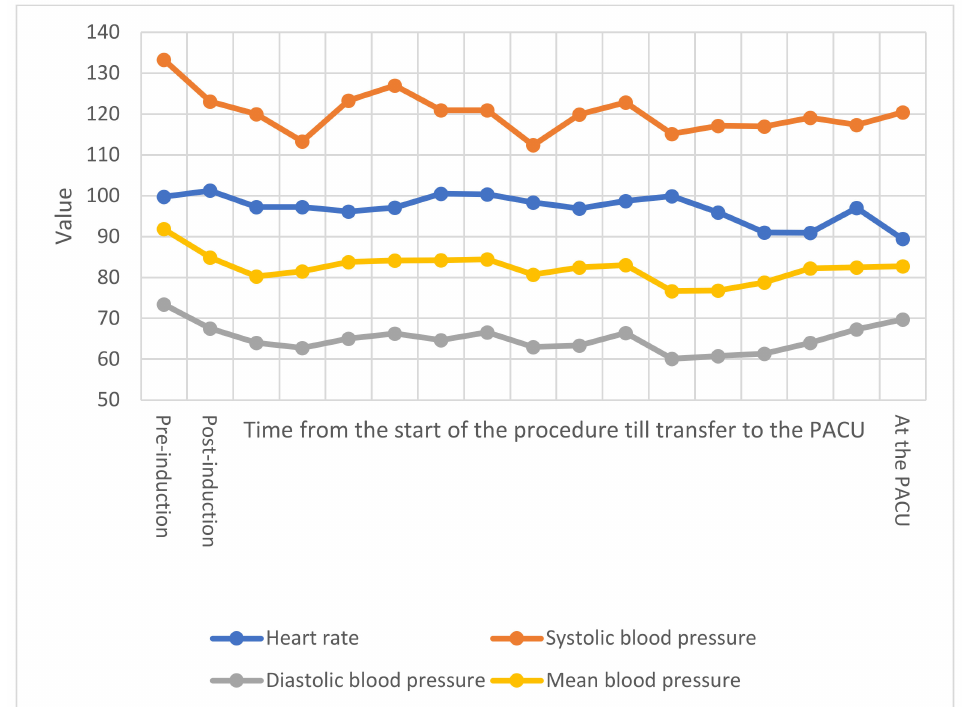
Figure 2. Vital signs in COVID-19 negative patients. The x -axis represents the timing of vital signs obtainment. Intraoperatively, vital signs were documented every 5 min until transfer to the PACU. The y -axis represents the value of vital signs, measured in beats per minute (BPM) for heart rate, mmHg for systolic, diastolic, and mean blood pressure. PACU: post anesthesia care unit. Vital signs are presented along with comparison with COVID-19 positive group in Supplementary Table S1.